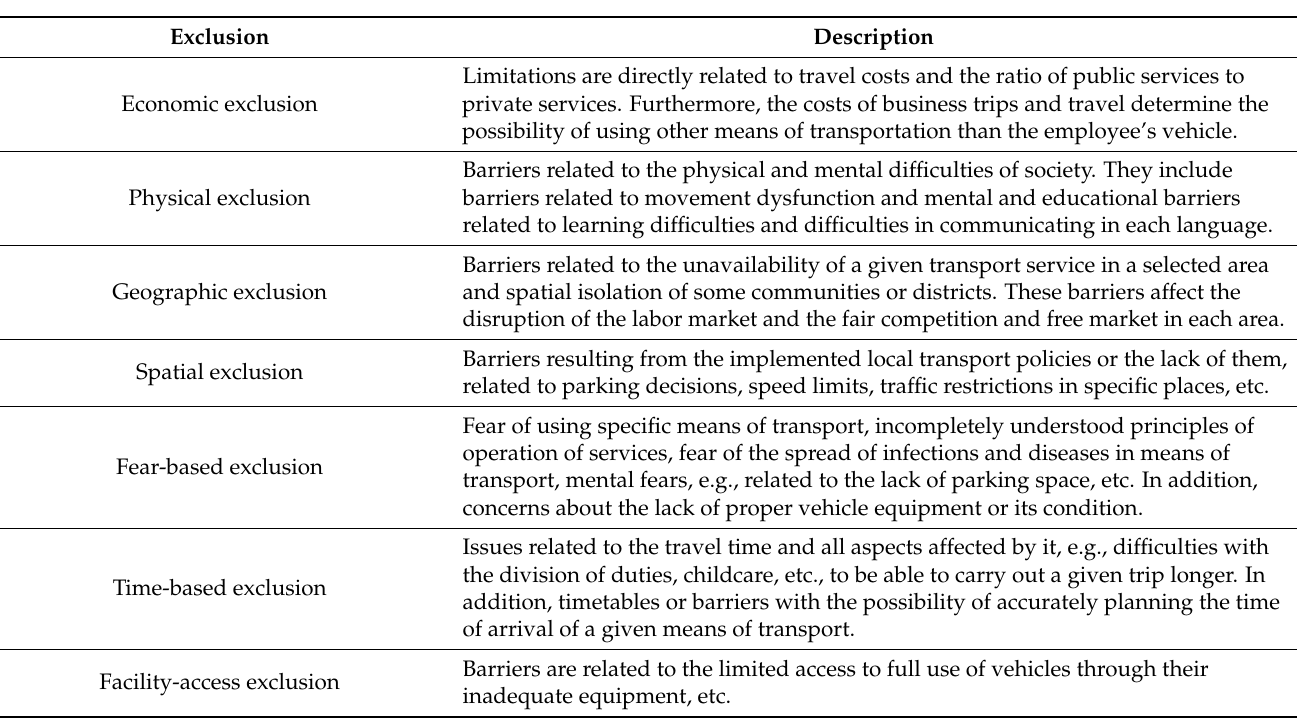
Table 1. Transport social exclusion